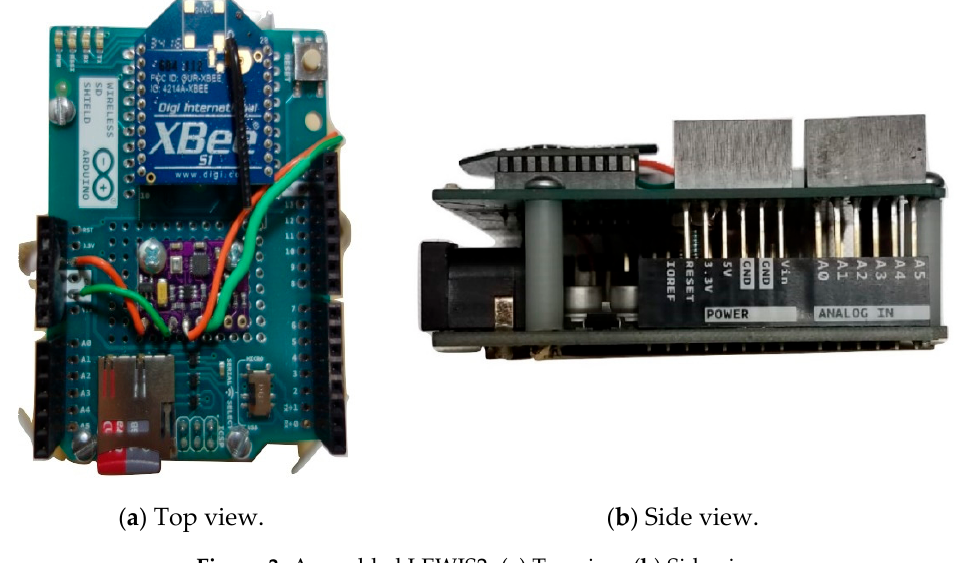
Figure 3. Assembled LEWIS2: ( a ) Top view, ( b ) Side view. Table 2. Essential sensing platform components of LEWIS2.